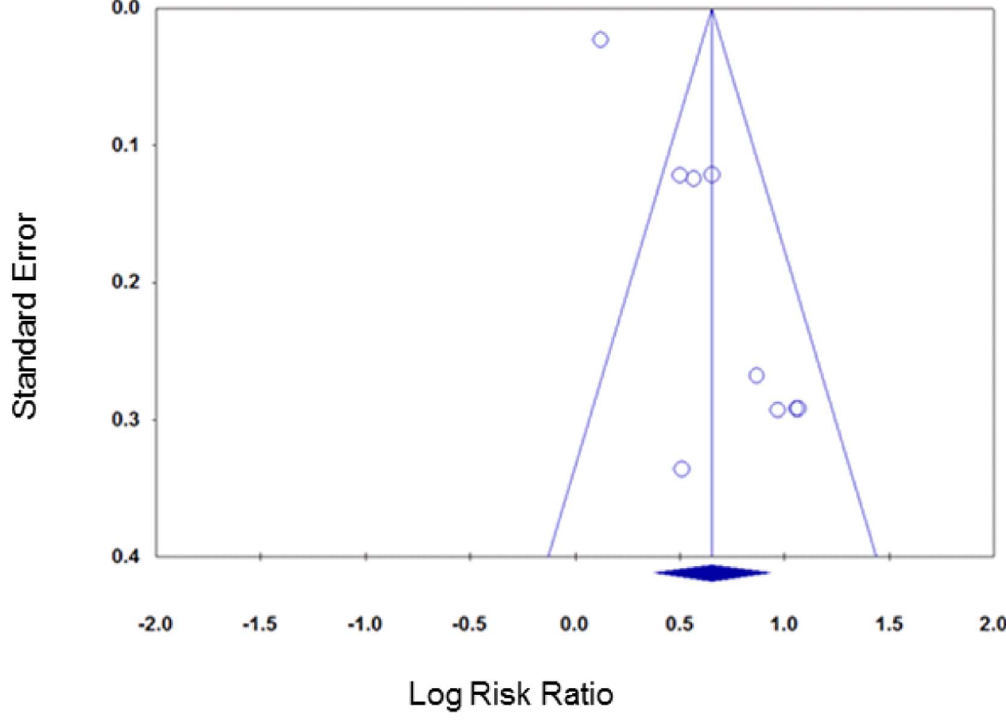
Figure 13. Contour enhanced funnel plot, attendance at vaccination and screening.